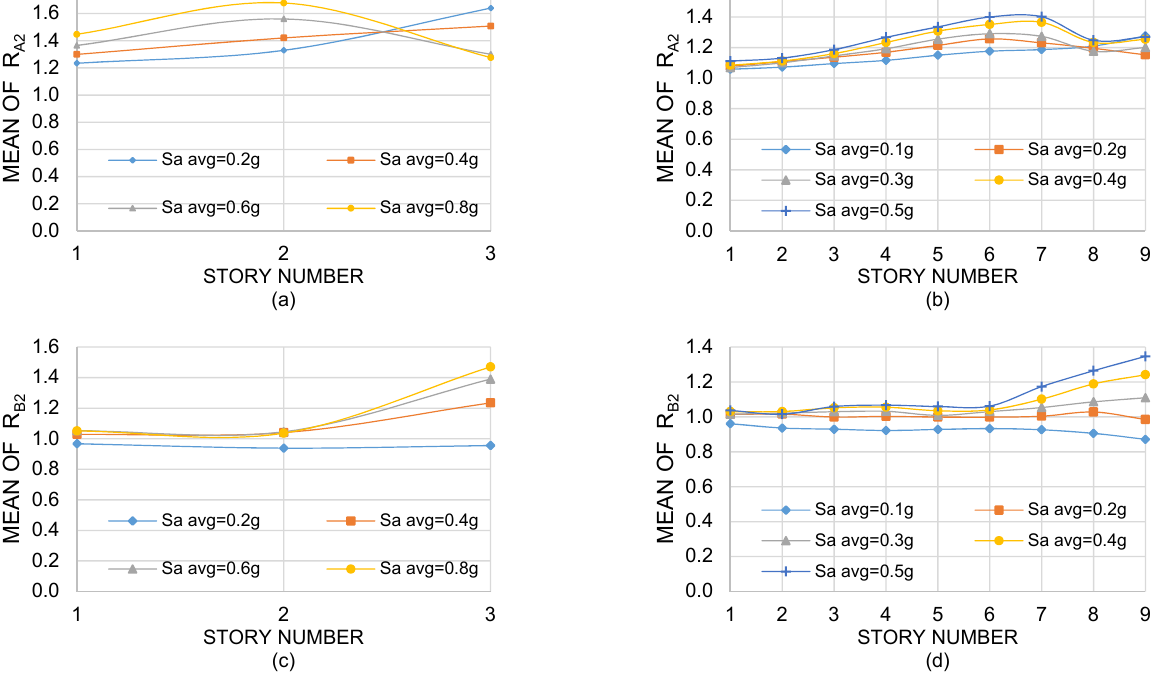
Figure 14. Mean values of R A 2 and R B 2 , exterior columns, NS : ( a , b ) R A 2 Models 1 and 2, respectively; ( c , d ) R B 2 Models 1 and 2, respectively.